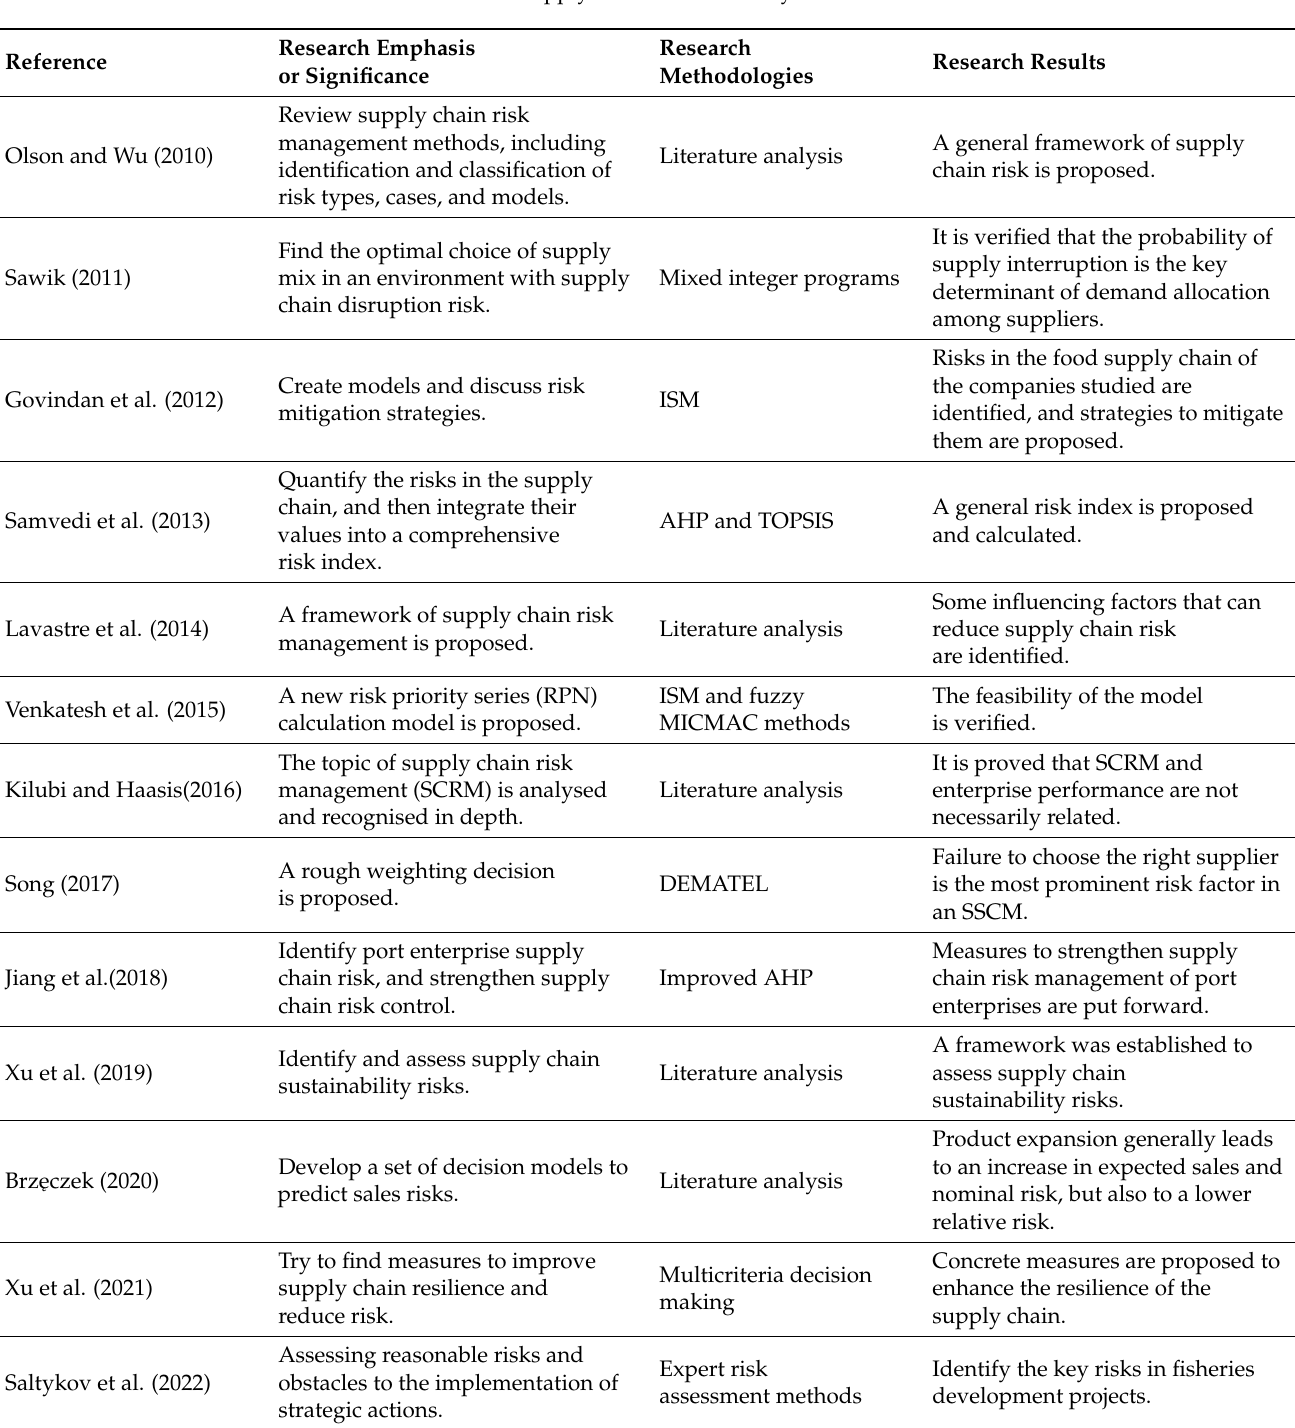
Table 1. Sustainable supply chain risk summary